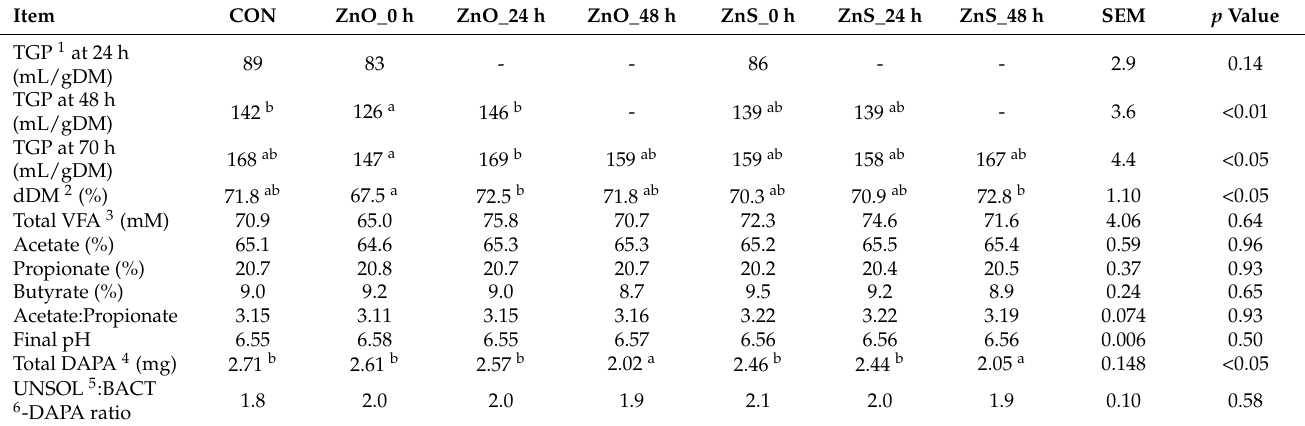
Table 5. Influence of inorganic Zn source and addition time on fermentation